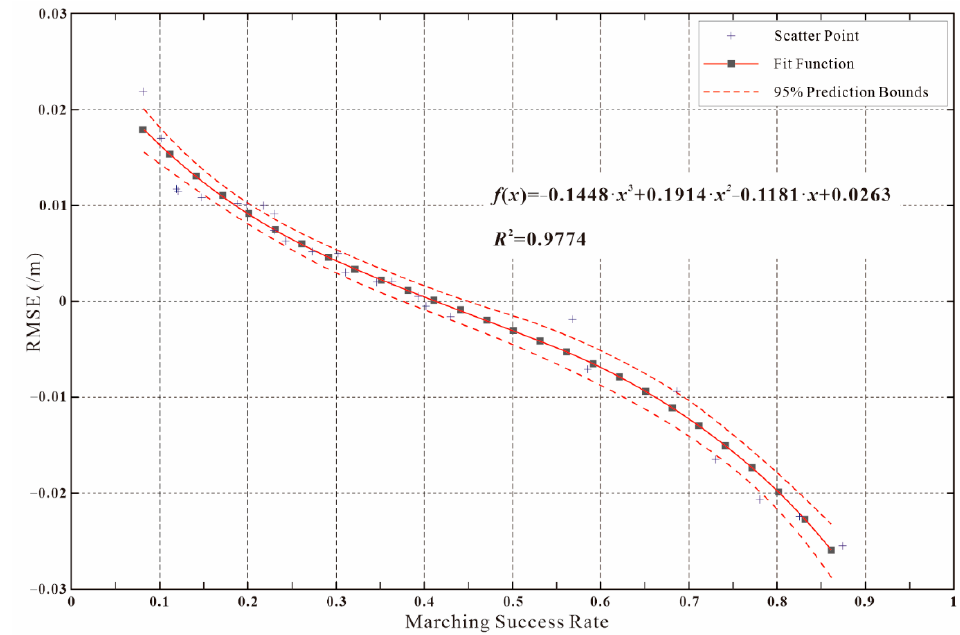
Figure 7. The relationship between the matching success rate and the pose error.